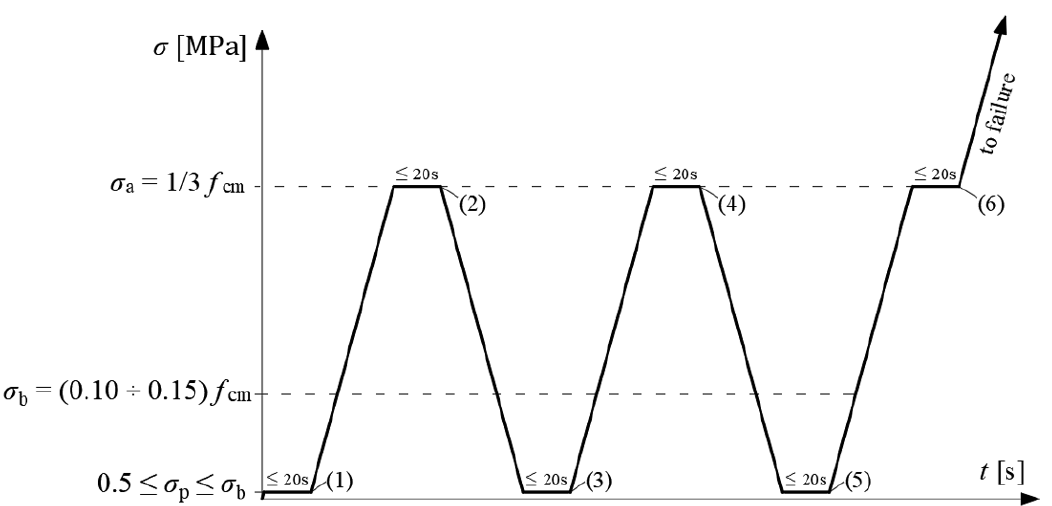
Figure 3: Investigation of stabilized secant elasticity modulus of concrete according to method